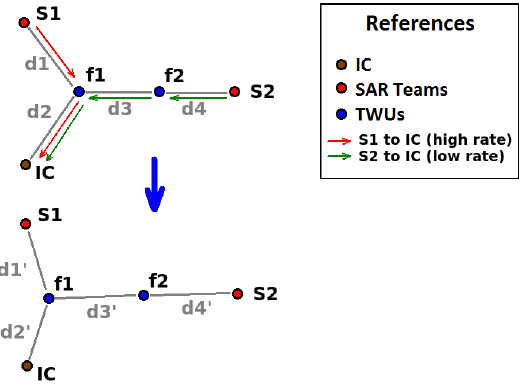
Figure 5. Dynamics of the adaptive network model.